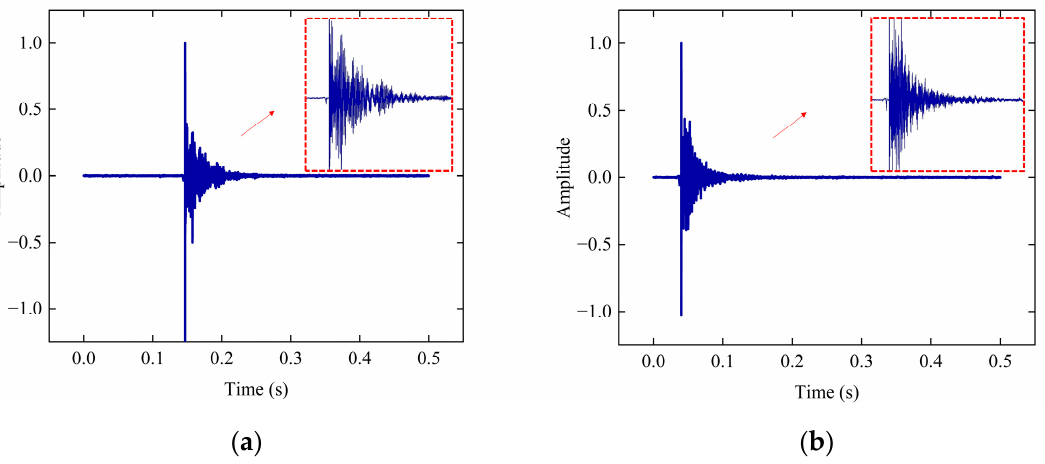
Figure 6. Time domain: ( a ) time domain of the damaged support bar; ( b ) time domain of the healthy support bar.